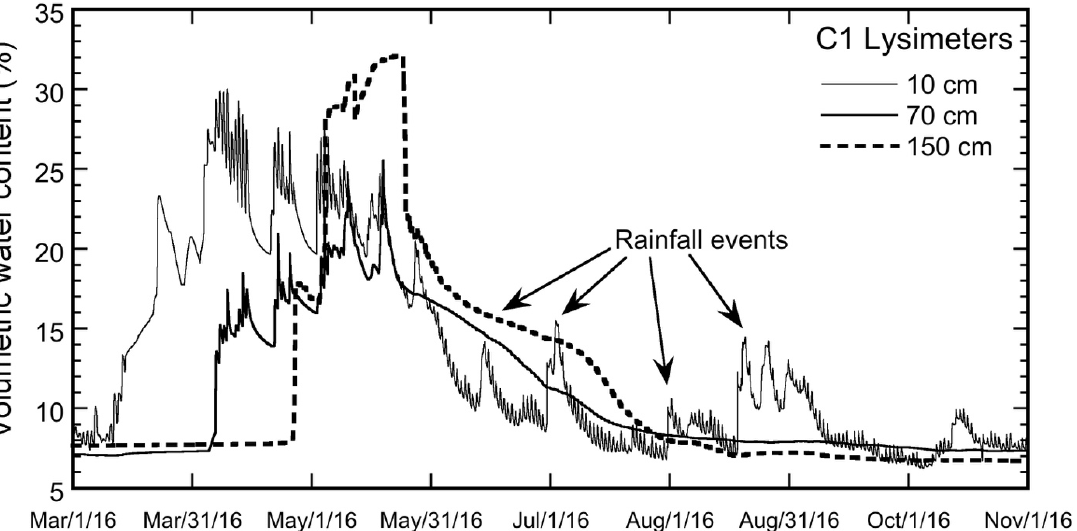
Figure 6. Seasonal volumetric soil moisture change measured at 10-min intervals at depths of 10, 70 and 150 cm below the surface at site C1 in 2016. Data from (colorado.edu/mrs/; accessed on 12 October 2016).